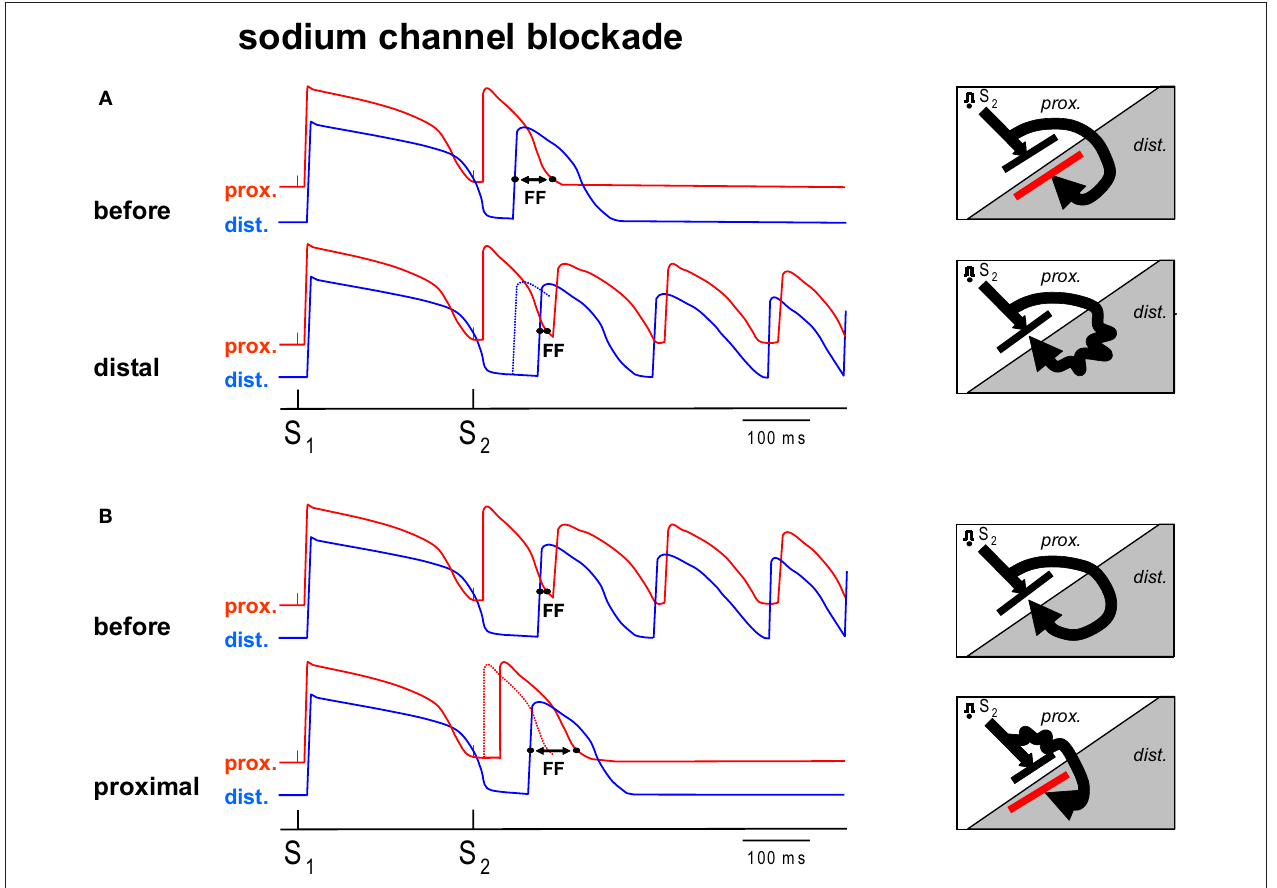
Figure 1 | Diagram of the hypothesis. (A,B) Each show two hypothetical action potential tracings from two sides of a region of repolarization dispersion. The distal (dist.) side of this region has a prolonged action potential compared to the proximal side (prox.). Each tracing shows the response of a basic stimulus (S1) and a premature stimulus (S2). The S2 is conducted with a delay towards the distal side because of unidirectional block between the regions. The Fibrillation Factor (FF) is defined by the difference in proximal repolarization time and the distal activation time of the premature